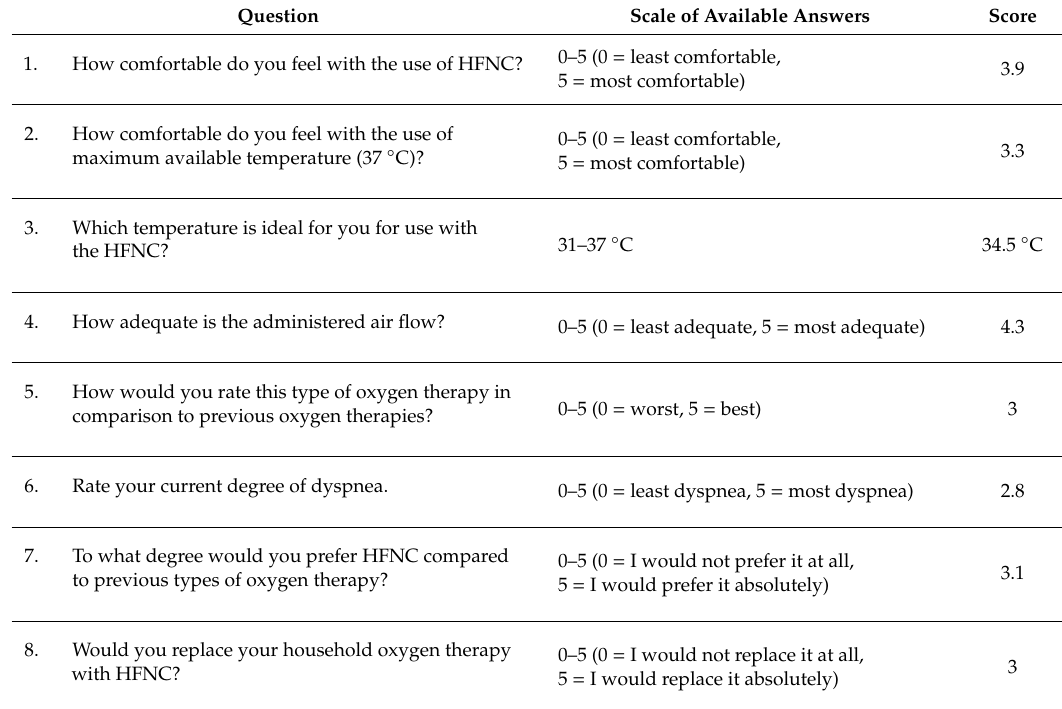
Table 4. Qualitative questionnaire about the use of high-flow oxygen through nasal cannula